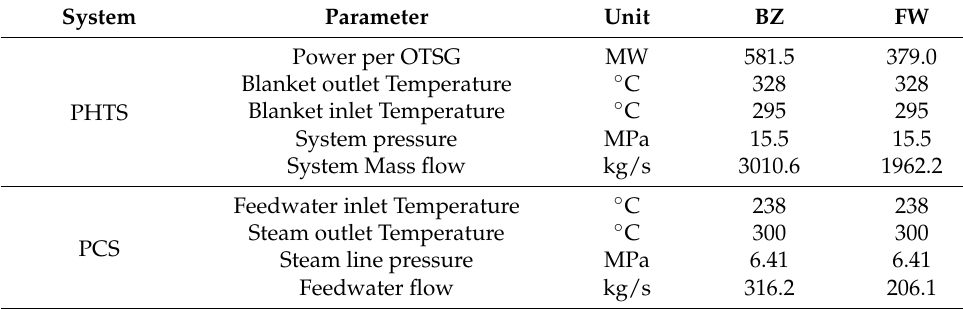
Table 1. Input data considered to perform the BZ and FW OTSG design.